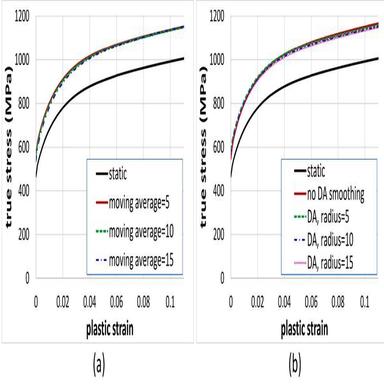
Effect of smoothing on the VFM identification results (identified Lim-Huh curves at the strain rate of 200 s − 1 , DP780): (a) temporal smoothing effect with different averaging points (DA, radius = 10) and (b) spatial smoothing effect with different DA radius size (moving average = 5).